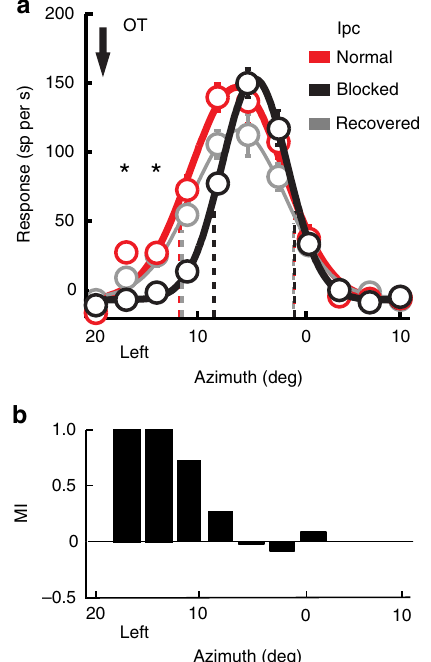
Figure 5 | Effect of Ipc blockade on response modulation at non-aligned sites in the OT. ( a ) Data from a single OTunit for a non-aligned OT-Ipc pair. VRF locations (azimuth, elevation): OT (L6, (cid:2) 6); Ipc (L19, (cid:2) 5). Downward arrow: location of the Ipc VRF centre. Asterisks: stimulus locations that did not drive the OTunit during Ipc blockade. Conventions are the same as in Fig. 2. ( b ) Response modulation index calculated from the Gaussian fits shown in a . The modulation index (MI) was calculated only for those locations that yielded a significant response before blockade.